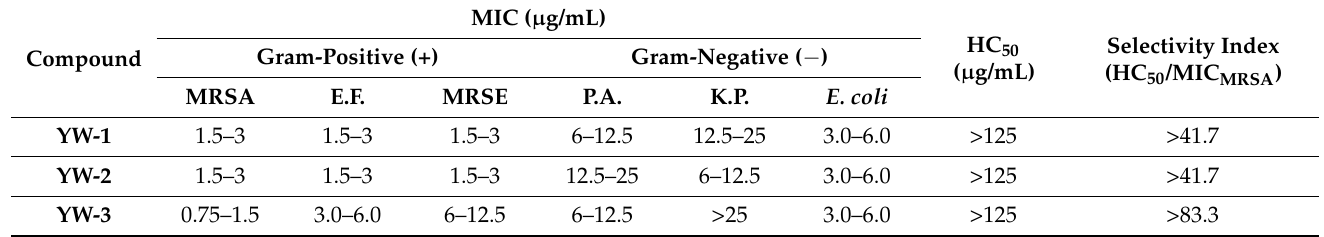
Table 1. Antibacterial activity, hemolytic activity, and selectivity of dendrimeric γ -Aapeptides. “—” means not